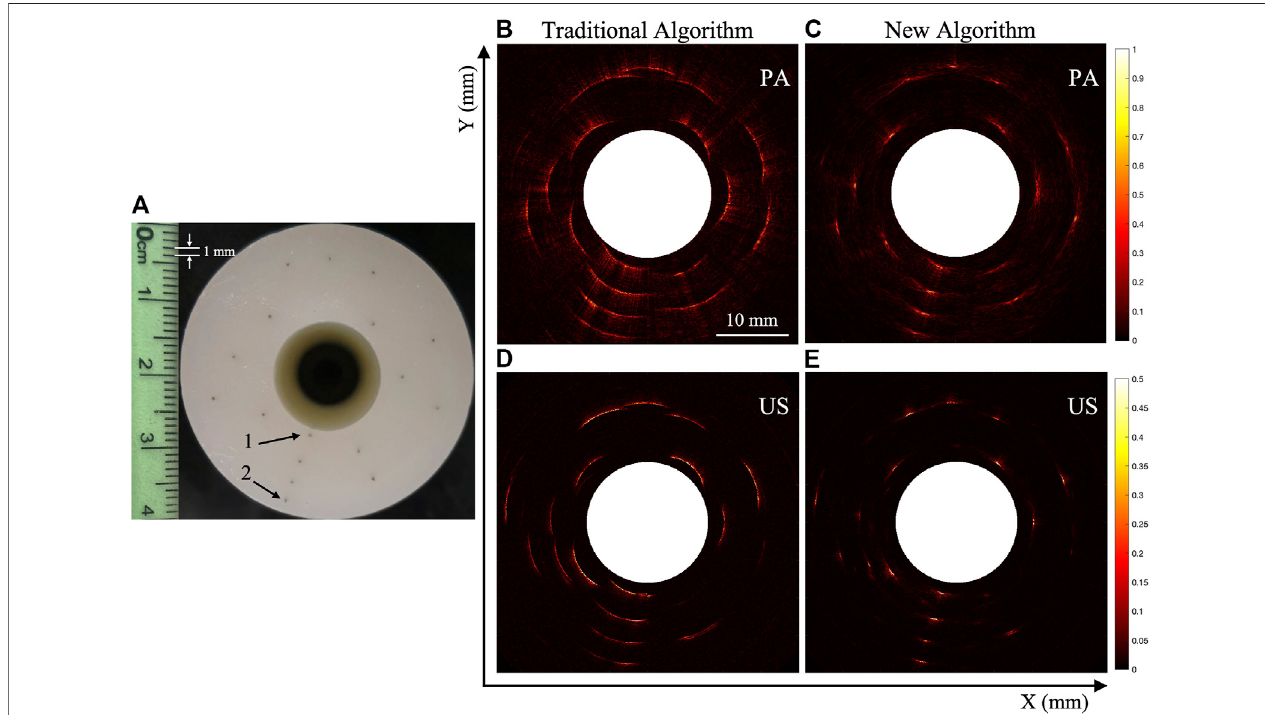
FIGURE 5 | Experimental imaging results of photoacoustic/ultrasonic endoscopy of point targets. (A) The photograph of Phantom 1. (B,C) The photoacoustic results reconstructed by the traditional algorithm and new algorithm, respectively. (D,E) The ultrasonic results reconstructed by the traditional algorithm and new algorithm,